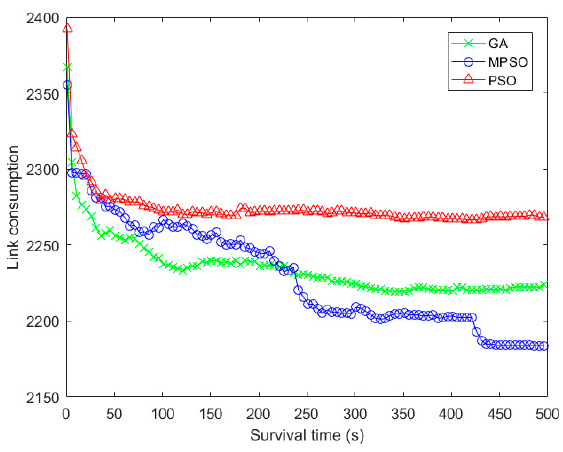
Figure 8. Comparison of link consumption with the iteration times.